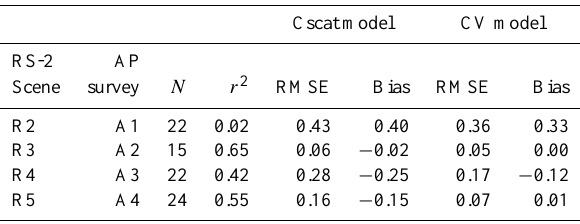
Figure 7. Comparison of pond fraction from R5 retrieved using the CV model (a) to a colour composite of a Landsat-7 ETM + satellite image bands 4 (red), 3 (green) and 2 (blue) acquired on the same day (b) . Dark lines visible in the bottom right portion of the Landsat-7 scene are due to the instrument Scan Line Correc- tor (SLC) failure. Original Radarsat-2 data © MacDONALD, DET- TWILER AND ASSOCIATES LTD., 2012 All Rights Reserved. Table 2. Relationships between measured and retrieved pond frac- tion from Radarsat-2 scenes R2 to R5.